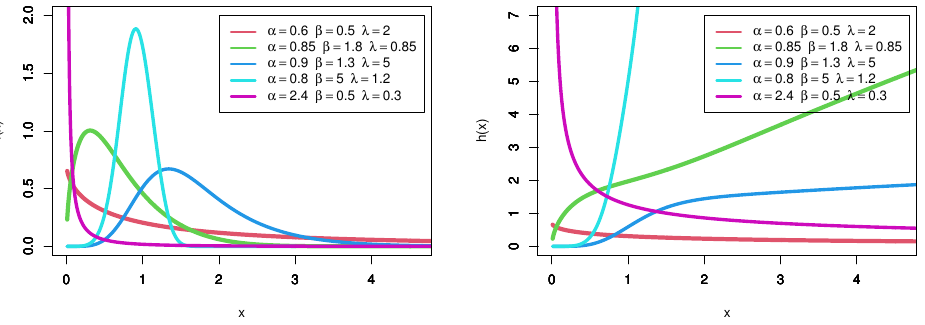
Figure 1. Probability density and hazard rate function with different shapes for the TIIHLW